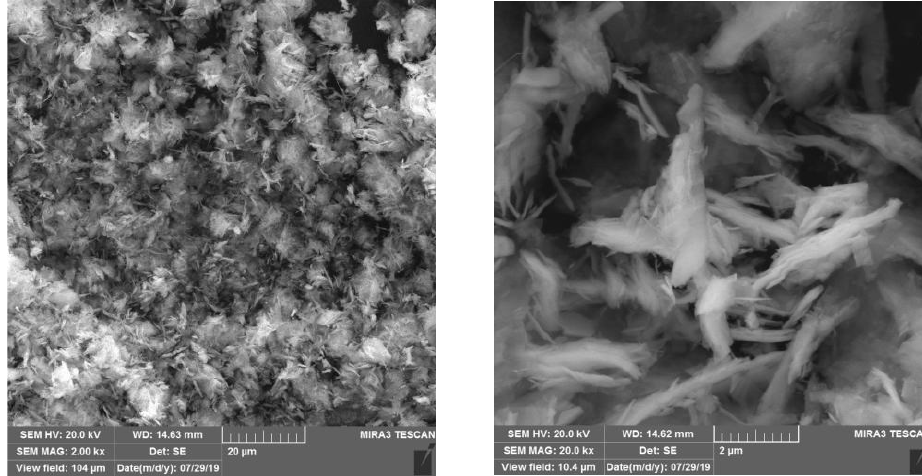
Figure 11. XRD pattern of precipitation products at different temperatures. In summary, the optimal process conditions for the sodium carbonate precipitation method are as follows: the feeding method is reverse precipitation, the n (RE 3+ )/ n (Na 2 CO 3 ) ratio is 1.0:1.6, the reaction temperature is 30 ◦ C, the Na 2 CO 3 concentration is 0.3 mol/L, the flow rate of the solution of REEs is 4 mL/min, the aging time is 4 h, and seed crystals are not added. Under these conditions, the total precipitation efficiency of the REEs was 99.93%, and the obtained carbonate products were feathery with a more uniform particle size distribution and good filtration performance (Figure 12). The RE 2 (CO 3 ) 3 was washed twice with 90 ◦ C water (liquid-to-solid (L/S, 100 mL distilled water/50 g hydroxide): 2:1) to ensure the purity of the subsequent RE x O y . During the washing stage, the loss of REEs is 0.81%. Thus, the total recovery efficiency of REEs is 99.12% after transformation and washing.